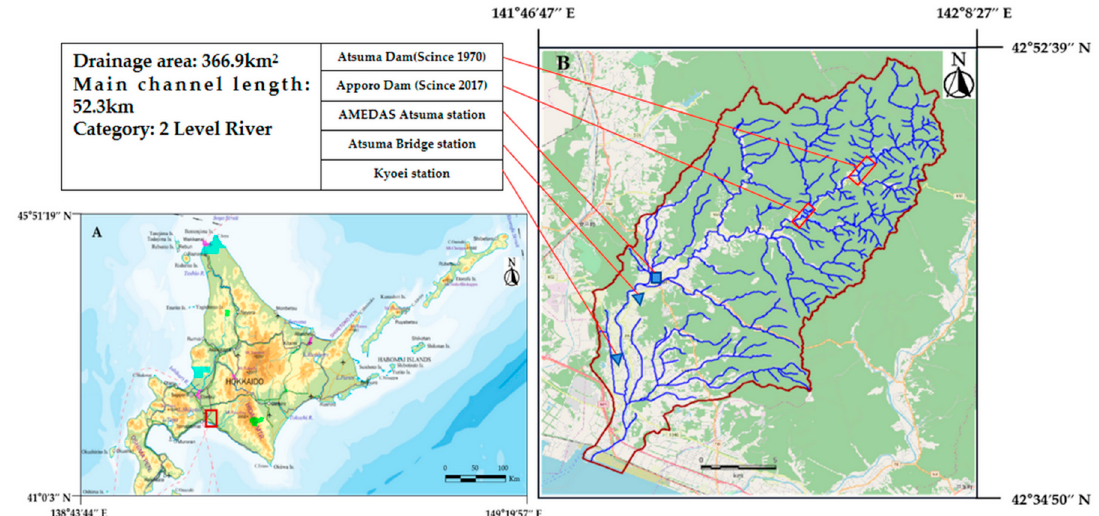
Figure 1. Map of Atsuma River basin (( A ) GSI: Geospatial Information Authority of Japan (2020) [26]; ( B ) Open Street Map Japan (2020) [27]).